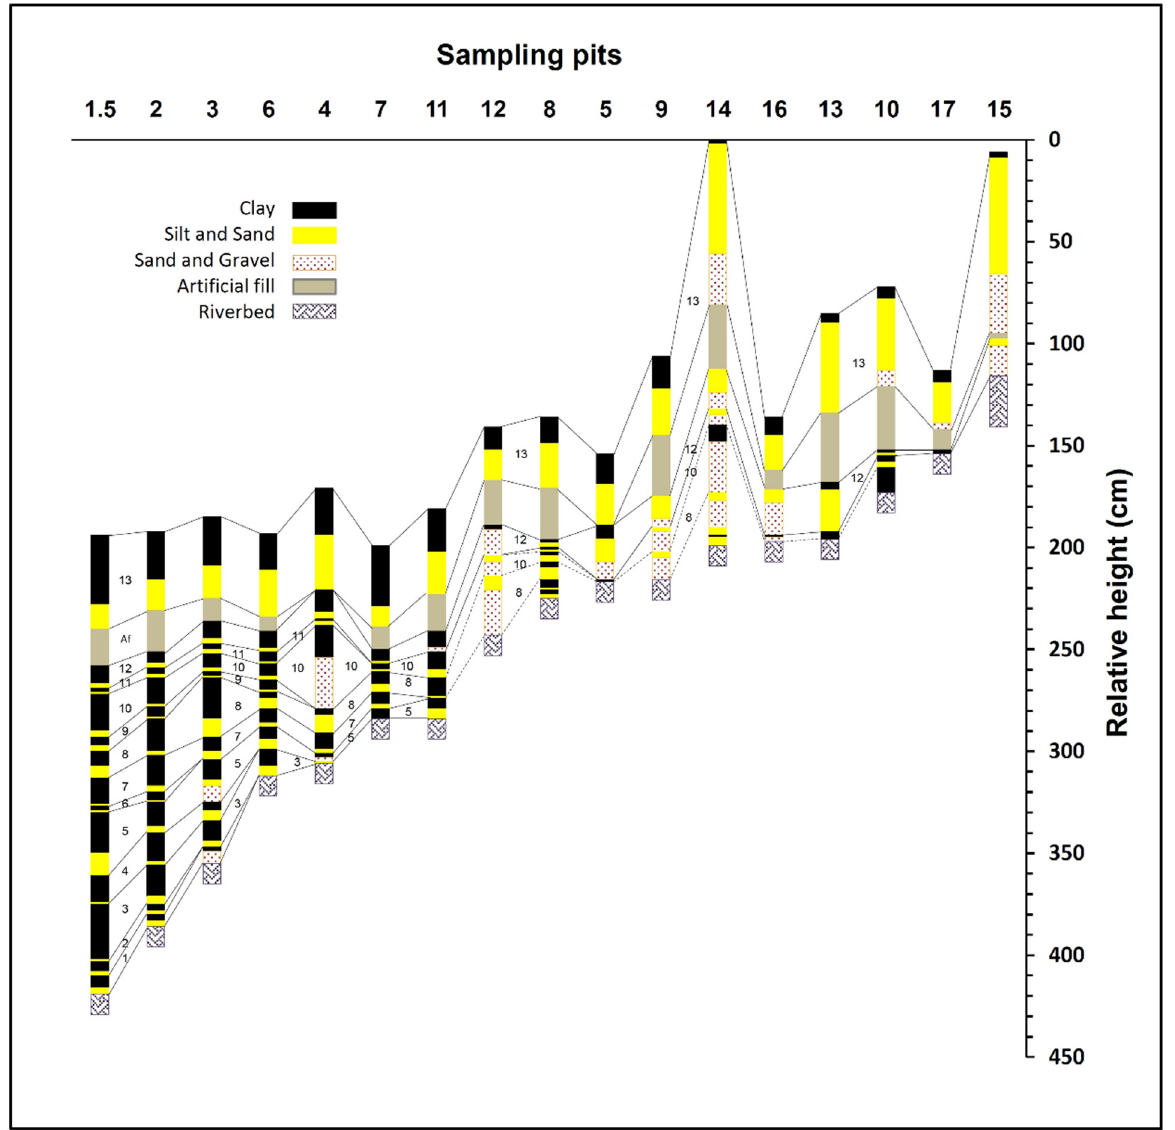
Figure 5. Spatial correlation between reservoir event deposits. Event-layer thickness is marked relative to the highest topographic level in the reservoir (Y axis-elevation relative to surface). The pre-reservoir riverbed was identified in all pits. Event deposits were identified based on sequences of gravel, sand and silt layers underlying clay. An artificial layer was identified in most of the area, except in pits 4 and 5 located at the reservoir’s margin. Stratigraphic correlation between 13 event layers is marked by continuous lines (certain correlation) and dashed lines (uncertain correlation).